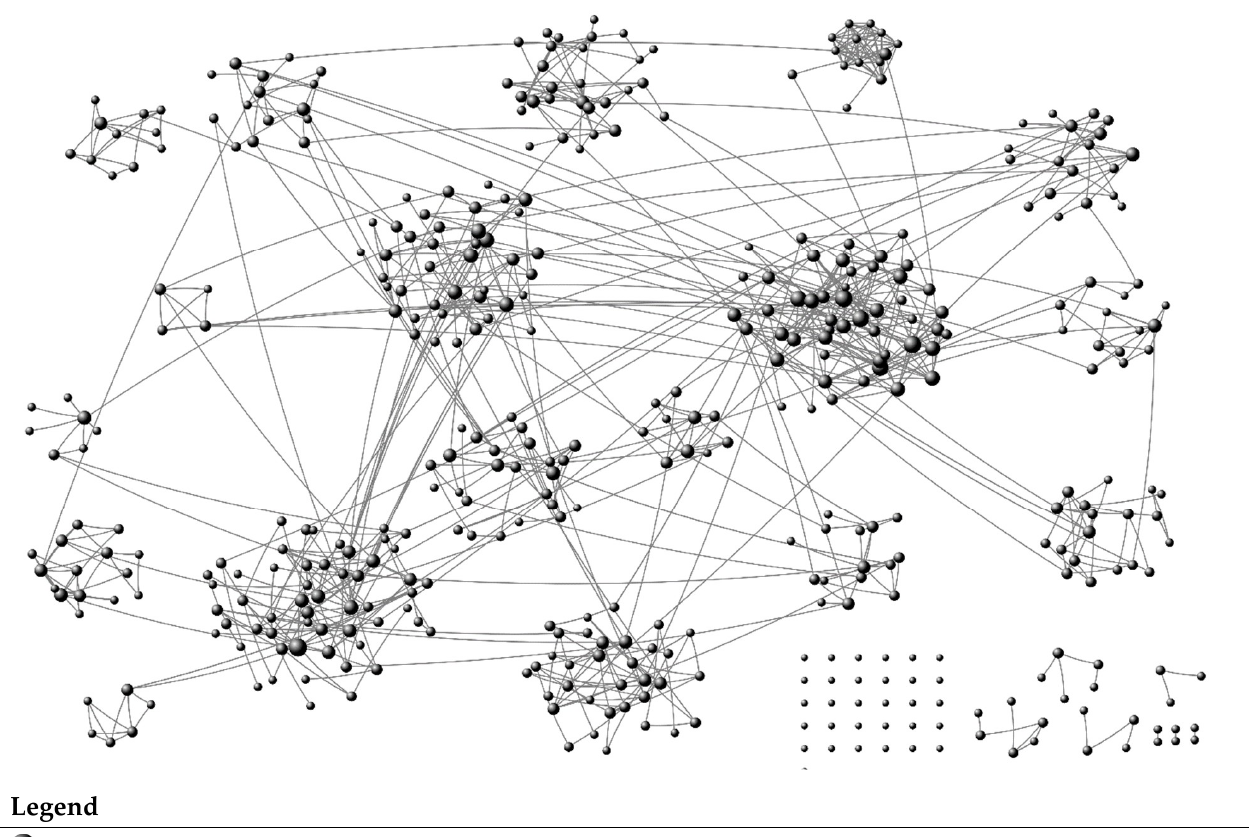
Figure 1. Diagram of the social network.